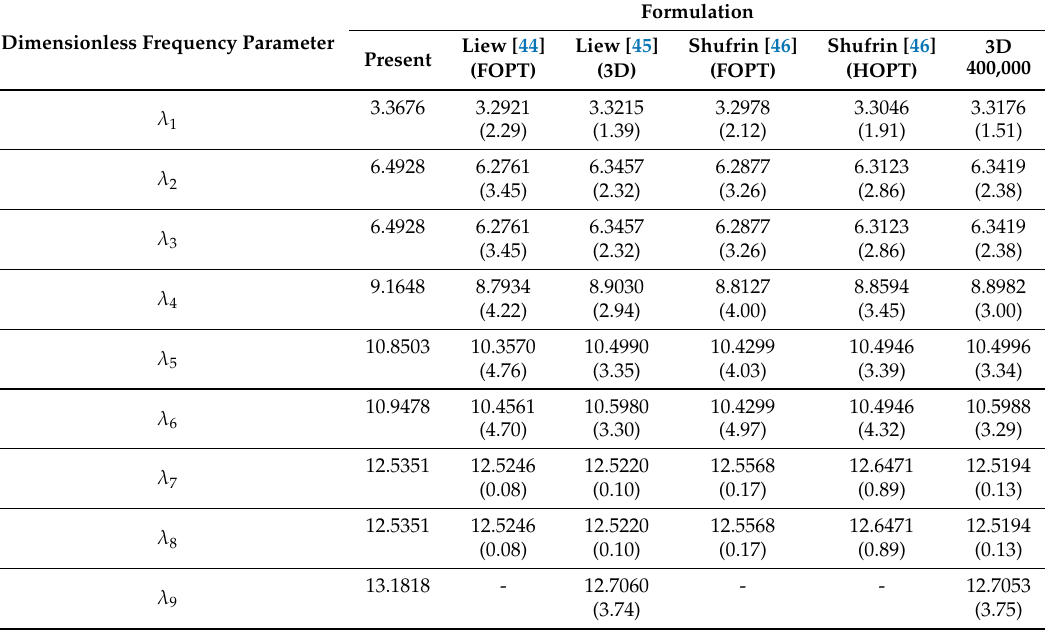
Table 8. Comparison of results for a square plate of ratio b / h = 10 and CCCC boundary conditions.